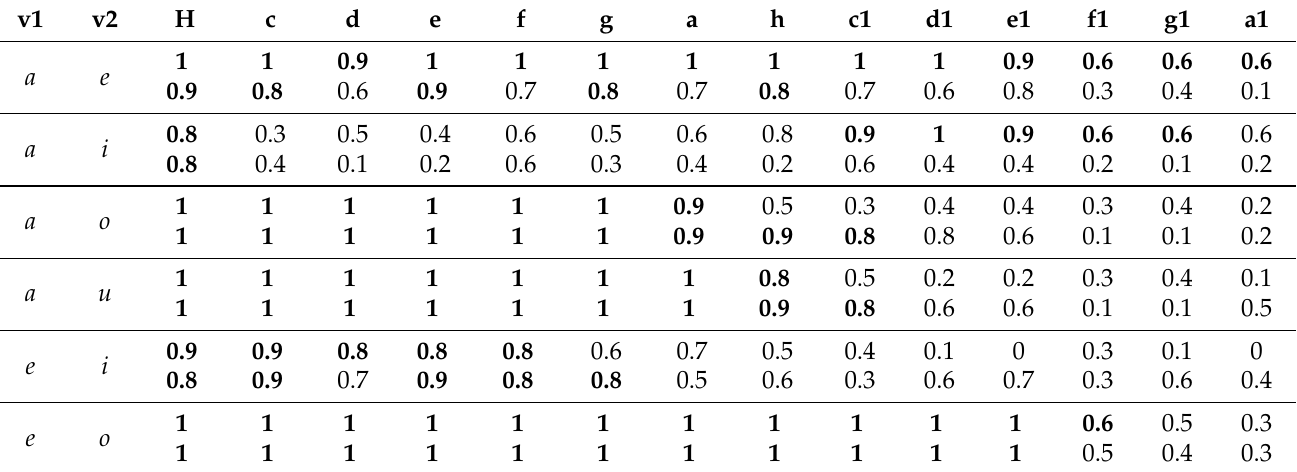
Table A4. Biserial correlation coefficients for the horizontal and vertical directivity indexes at each correlation coefficients are listed at the top and bottom in each cell. Bold letters indicate that there is a significant difference ( p > 0.05) between the vowel groups listed in the first and second